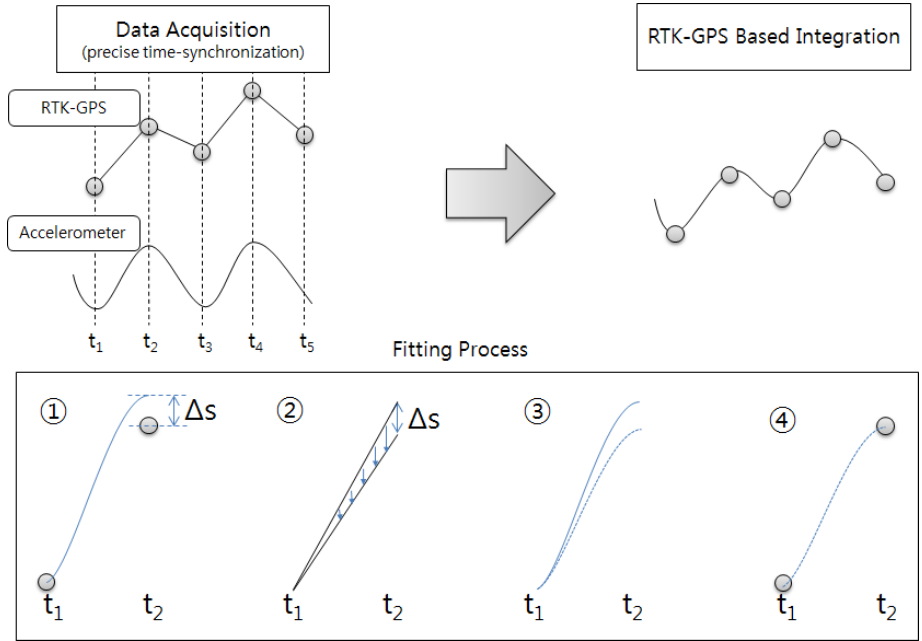
Figure 4. RTK-GPS-based simple integrated calculation process.